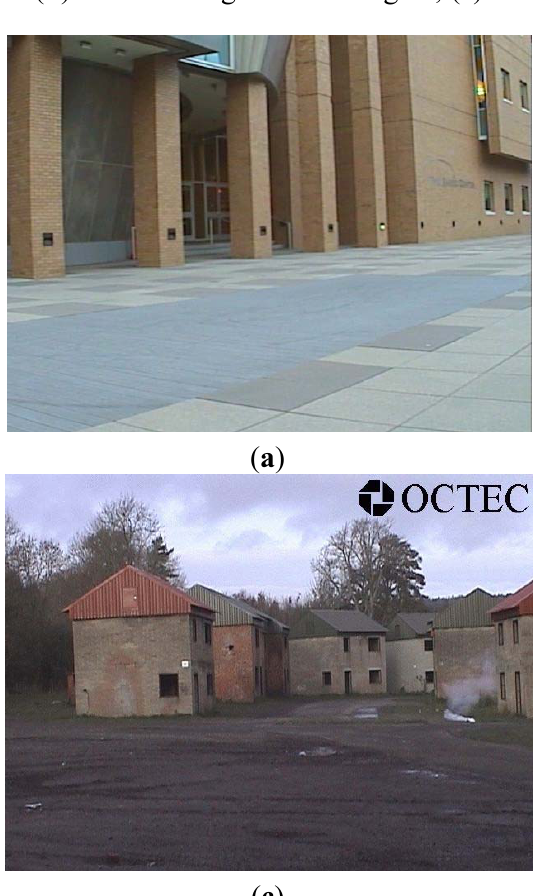
Figure 4. Two edge detection results of EO images via the Canny edge operator. ( a ) Original EO Image 1; ( b ) Detected edge of EO Image 1; ( c ) Original EO Image; ( d ) Detected edge of EO Image 2; ( e ) Detected edge of IR Image